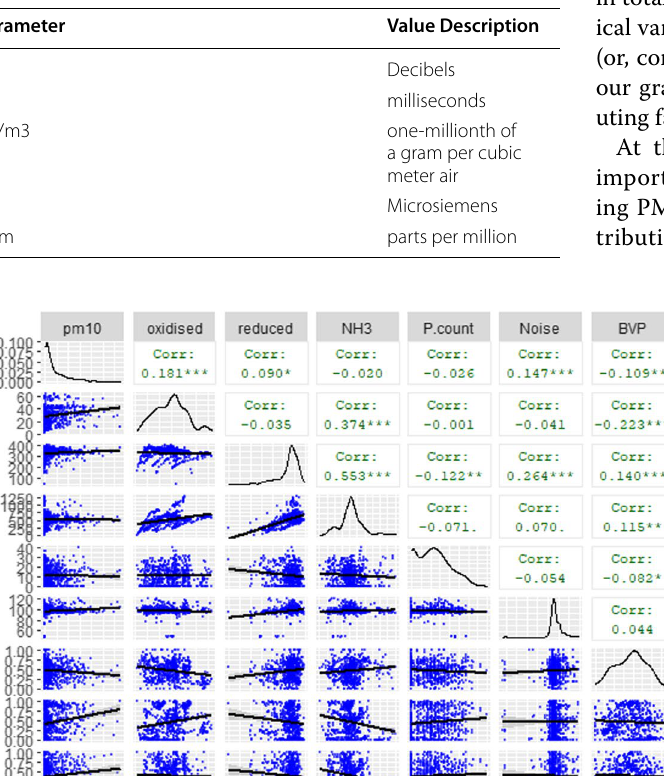
Table 2 Parameter Value-Based Description of Sensor Units